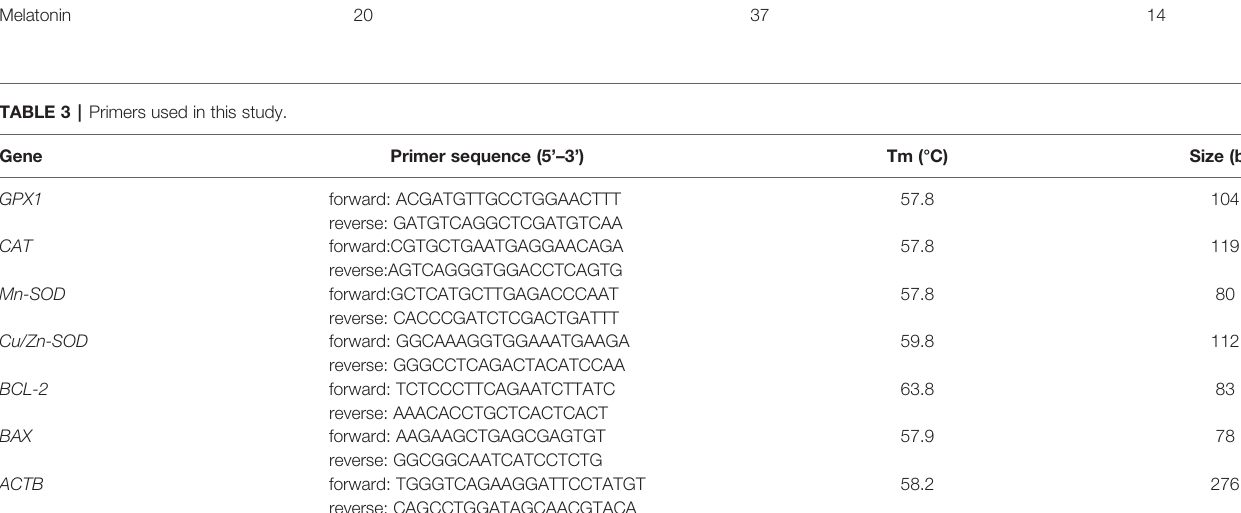
TABLE 2 | Embryo scores of the 143 vitri fi ed-warmed human cleavage-stage embryos. Groups